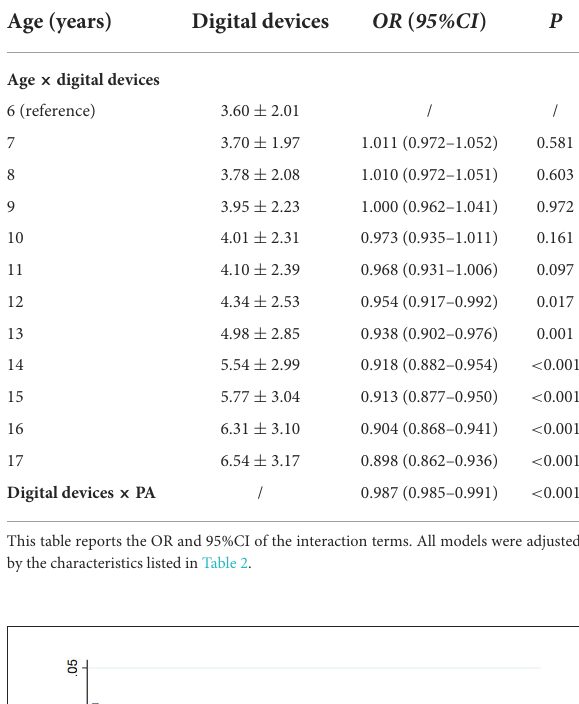
TABLE 3 The interaction effects of digital devices and age or PA on poor visual acuity.